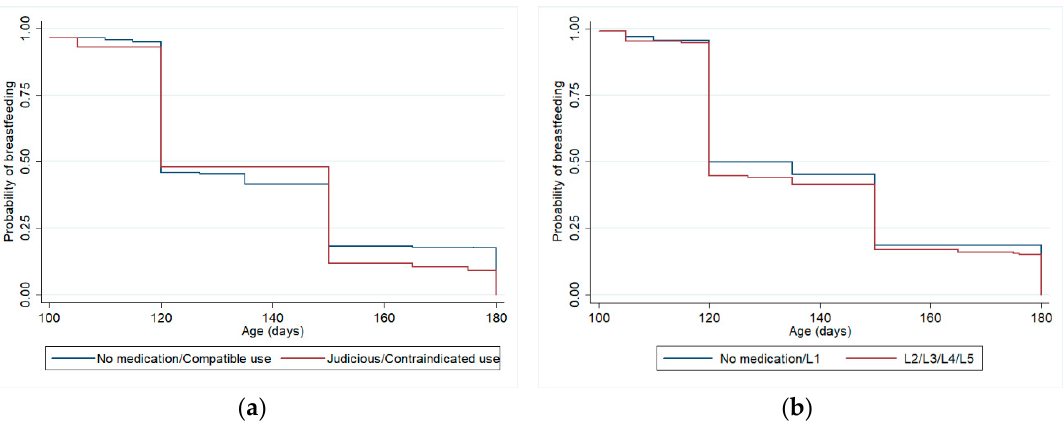
Figure 2. Kaplan-Meier curves (adjusted analysis *) for weaning from 3 to 6 months (excluding women who weaned before 3 months), according to maternal medication classified by Brazilian Ministry of Health Criteria ( a ) and Hale lactation risk categories ( b ). Pelotas (Brazil) Birth Cohort Study, 2015. * Analyses adjusted for maternal schooling and previous experience of breastfeeding .